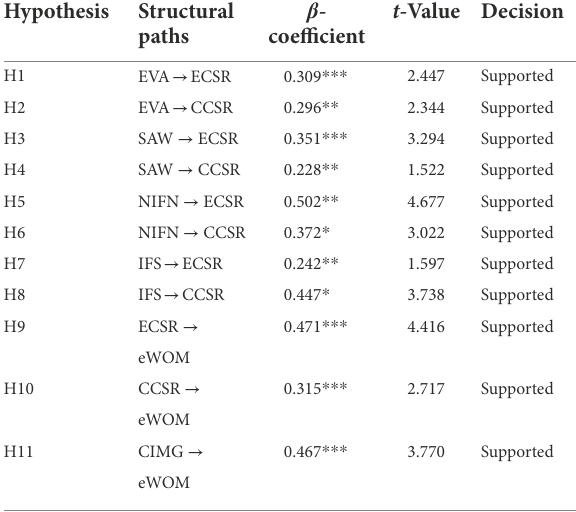
TABLE 6 The outcomes of hypothesis testing on the structures.